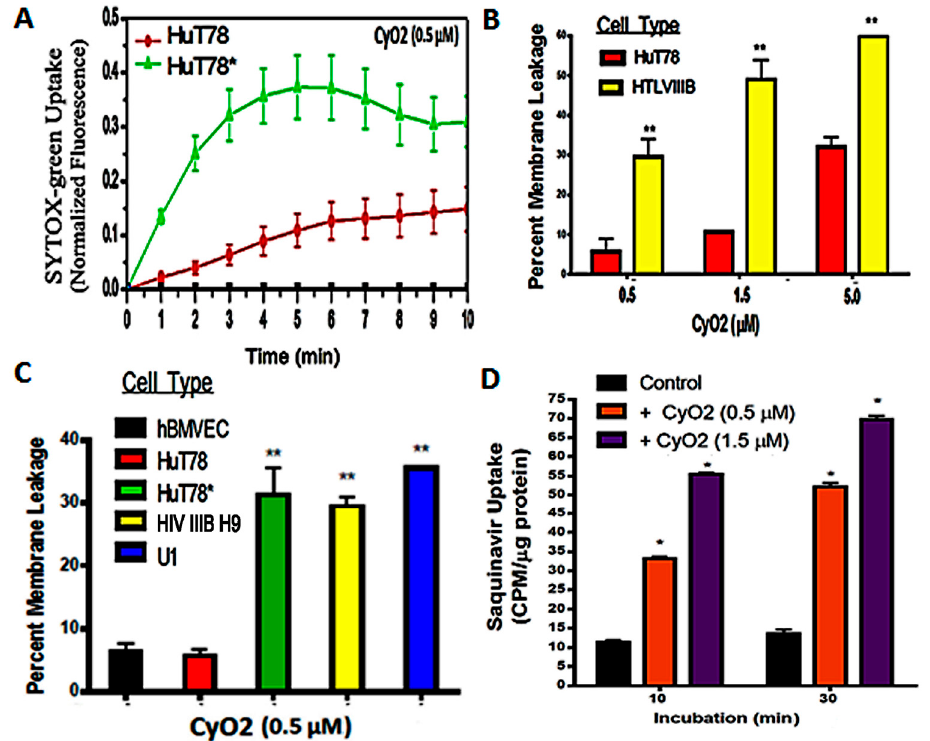
Figure 3. Effect of CyO2 on pore-formation and drug-uptake in HIV-infected cells. ( A ) Fluorimetric analysis of SYTOX-green uptake in uninfected HuT78 cells and HIV-infected HuT78* cells demonstrate temporal (0–10 min) changes in SYTOX-green fluorescence following exposure to CyO2 (0.5 µ M). ( B ) Dose-dependent effects of CyO2 (0.5–5.0 µ M) on SYTOX-green uptake in uninfected HuT78 and chronically-infected HIV IIIB H9 cells. ( C ) Comparative analysis of SYTOX-green uptake in primary hBMVEC cells, uninfected HuT78 cells, and productively-infected cells, HuT78* and HIV IIIB H9 cells, at 10 min post-exposure to CyO2 (0.5 µ M). Percent change in membrane leakage in CyO2-exposed cells, as compared to untreated control (0%) and in cells exposed to Melittin (100%) are shown. ( D ) Effect of CyO2 pre-exposure on radiolabeled saquinavir ( 3 H-SQV) uptake in HuT78 cells. Counts per minute (CPM) values were normalized to protein contents (CPM/ µ g protein). Non-hemolytic doses of CyO2 induced more pore-formation in productively-infected cells, which increased both SYTOX-green and 3 H-SQV uptake. (*, p < 0.05; **, p < 0.01)